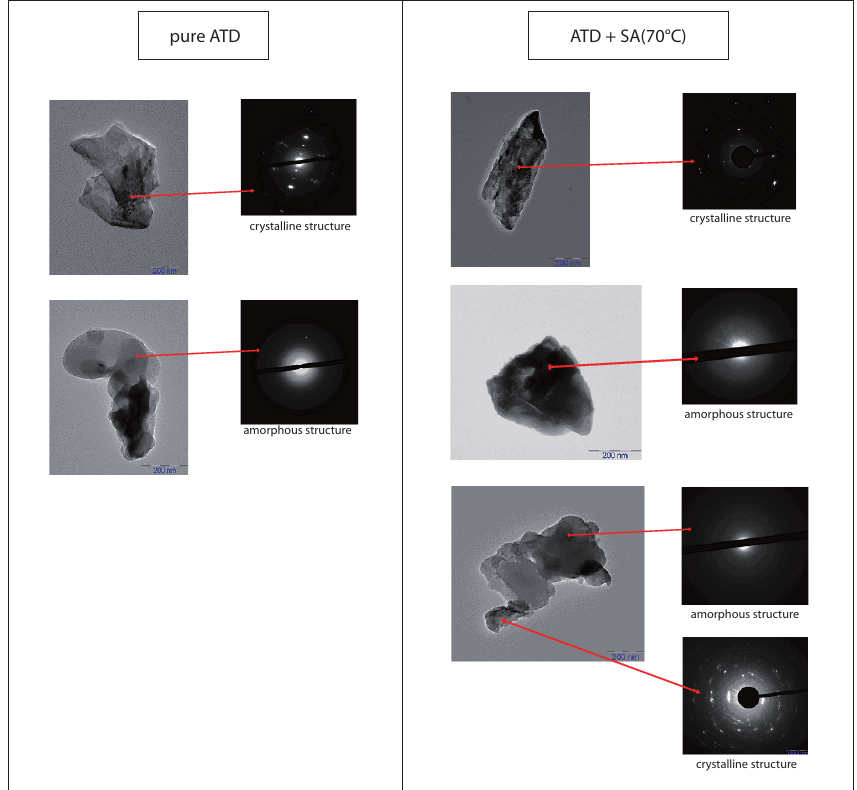
Fig. 2. Images resulting of Transmission Electron Microscopy (TEM) investigations for pure ATD (left panel) and ATD + SA(70 ◦ C) (right panel) are presented on the left of the panels. Additionally, results of electron diffraction are shown on the right of the panels where the red arrows indicated the investigated surface